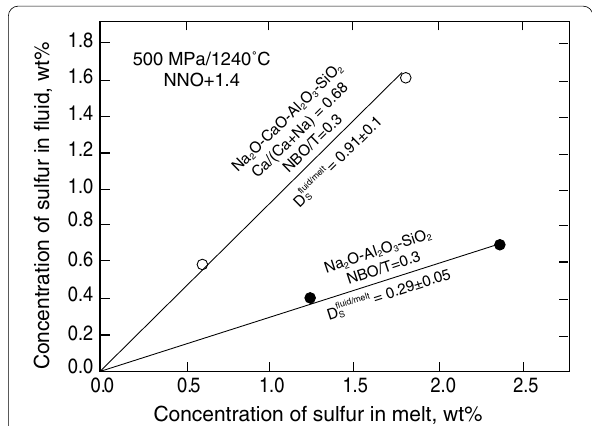
Fig. 9 Sulfur content coexisting aqueous fluid and hydrous melt as a function of their sulfur content at 500 MPa and 1240 °C with the oxygen fugacity controlled 1.4 log units above that of the NNO buffer for systems as indicated on diagrams. ( Modified after Zajacs 2015 )